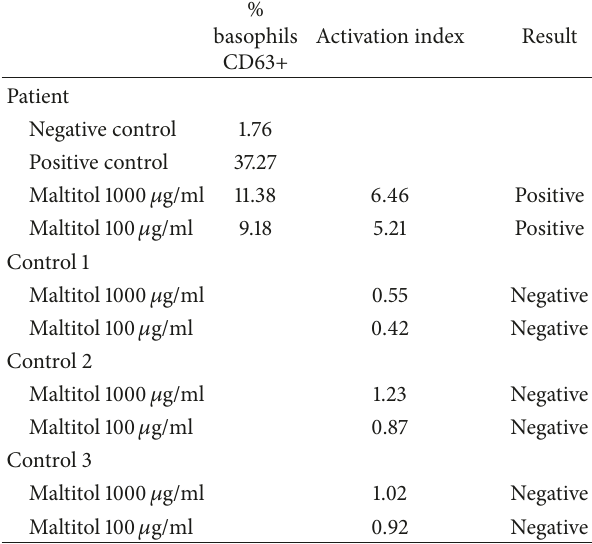
Table 1: Results of basophil activation and activation